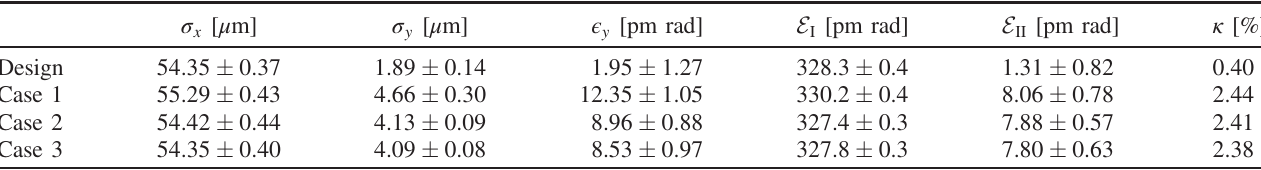
TABLE II. Impact of SCVDBs on beam sizes, vertical projected emittance in IDs (center of long straights), eigenemittances and on the = E emittance ratio κ ¼ E . All results are averaged over 20 straight sections and 10 error seeds. The standard deviation is also displayed. II I